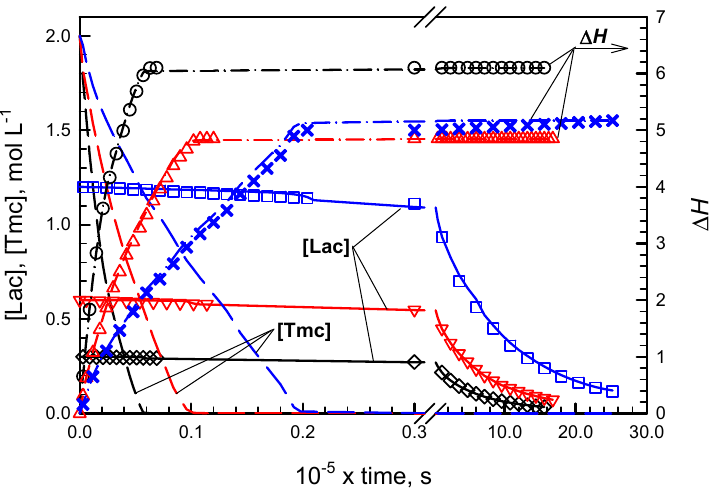
Figure 2. Experimental and simulated evolution of [ Lac ], [ Tmc ], and Δ H in copolymerizations initiated with R - Ini for different [ Lac ] 0 : 0.3 (black), 0.6 (red), and 1.2 mol · L − 1 (blue). Experimental data marked by symbols, simulated data by lines. Other initial conditions: [ Tmc ] 0 = 2 mol · L − 1 . [ R - Ini ] 0 = 2 × 10 − 3 mol · L − 1 (+ [ i PrOH] 0 = 4 × 10 − 3 mol · L − 1 due to in situ synthesis of Ini